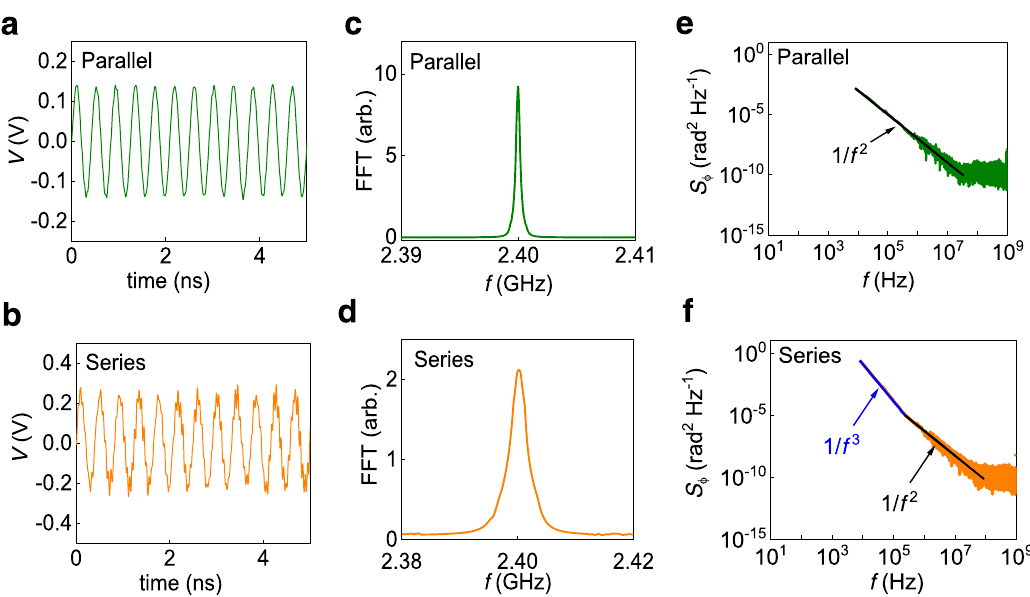
Fig. 4 Time-domain measurements and phase noise analysis of injection-locked four synchronized oscillators at P rf = − 20 dBm. a , b 5 ns time-domain trace measured in the parallel con fi guration at I dc = 3.4 mA ( a ) and series con fi guration at I dc = 1.3 mA ( b ). c , d Fast Fourier transform for the 1 ms time- domain trace in parallel ( c ) and series ( d ) at I dc = 3.4 mA and 1.3 mA, respectively. e , f Corresponding phase noise for 1 ms time-domain trace in parallel ( e ) and series ( f ), where the solid black and blue lines in series connections ( f ) shows the fi tting corresponding to 1/ f 2 and 1/ f 3 phase noise,